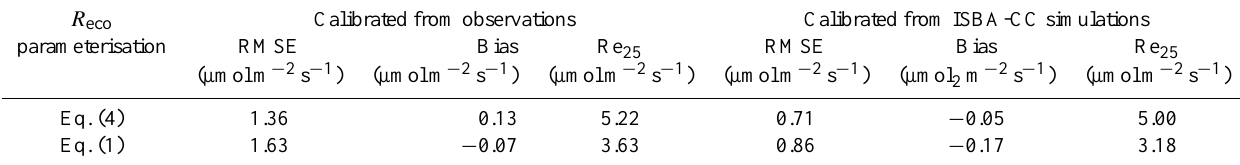
Table 2. Calibration of Re 25 from (left) nighttime observations of NEE (i.e. ecosystem respiration), filtered by wind direction, u ∗ above 0.16ms − 1 , and the absence of water deposition and (right) using the ecosystem respiration simulated by the ISBA-CC model. The calibration is performed by minimising the RMSE between either Eq. (4) or Eq. (1) and the observations or the ISBA-CC simulations. R eco Calibrated from observations Calibrated from ISBA-CC simulations parameterisation RMSE